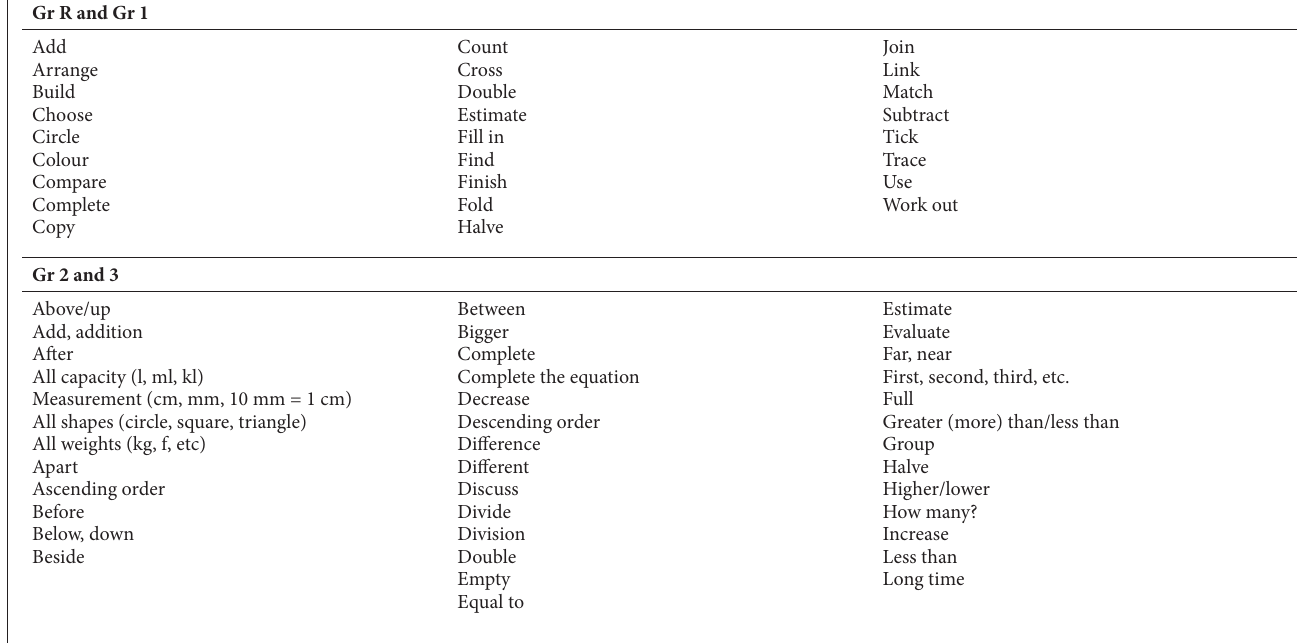
Table B1. Vocabulary items in the foundation-phase curriculum for English first language (Department of Education,